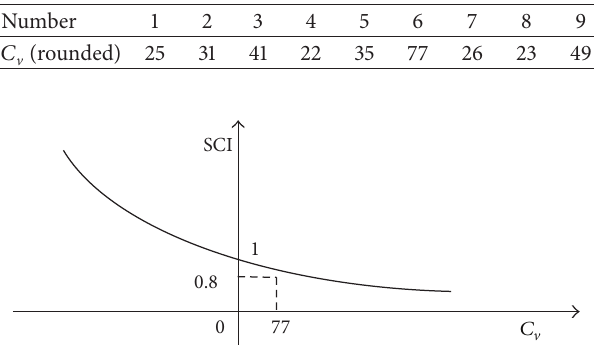
Figure 3: Graph of relationship between SCI and 𝑃 - 𝑉 conflict.